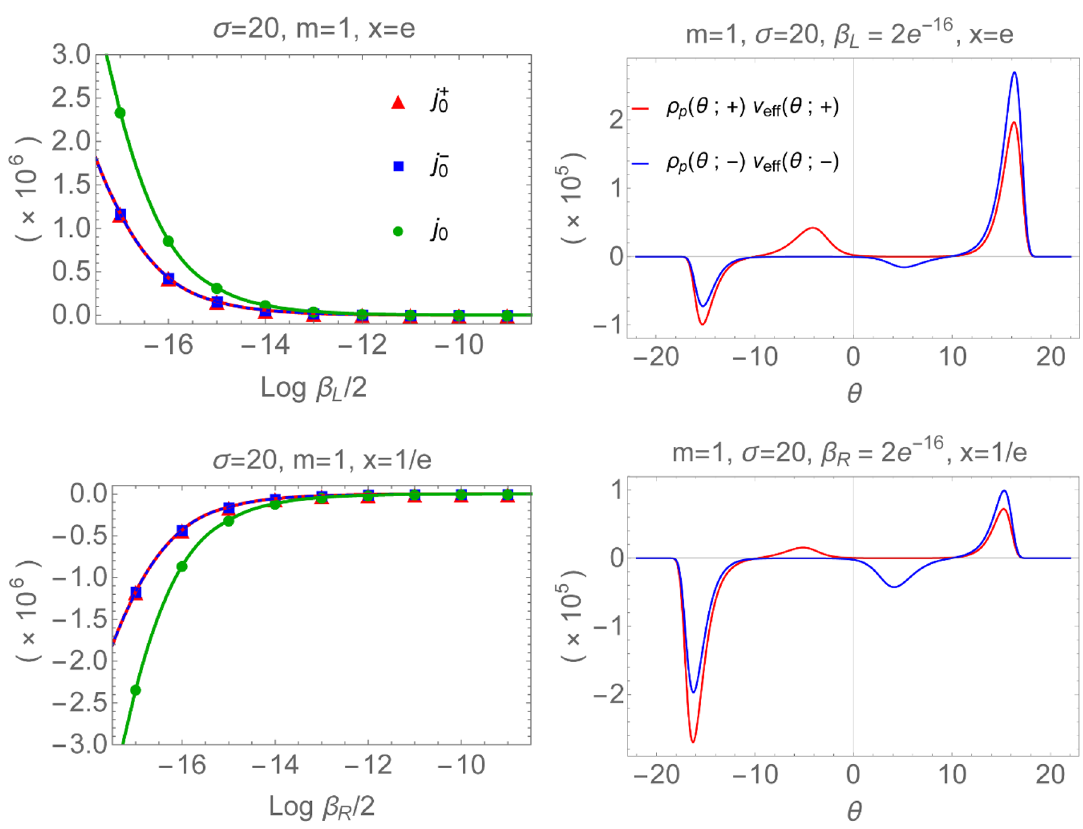
Figure 12 . Left panels: total particle current j 0 (circles, green), particle current associated to particle + (triangles, red) and to particle (cid:0) (squares, blue). The vertical axis labels should be multiplied by a factor 10 6 , as indicated. Right panels: the functions (cid:26) p ( (cid:18) ; (cid:6) ) v e(cid:11) ( (cid:18) ; (cid:6) ) whose inte- gration gives the particle current. The vertical axis labels should be multiplied by factors 10 6 and 10 5 , as